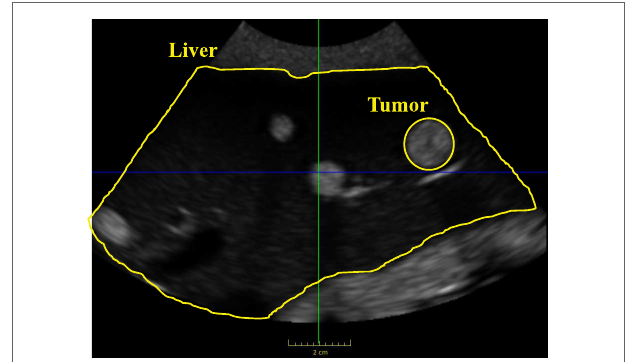
FIGURE 9 | Reference US image used in the experiments